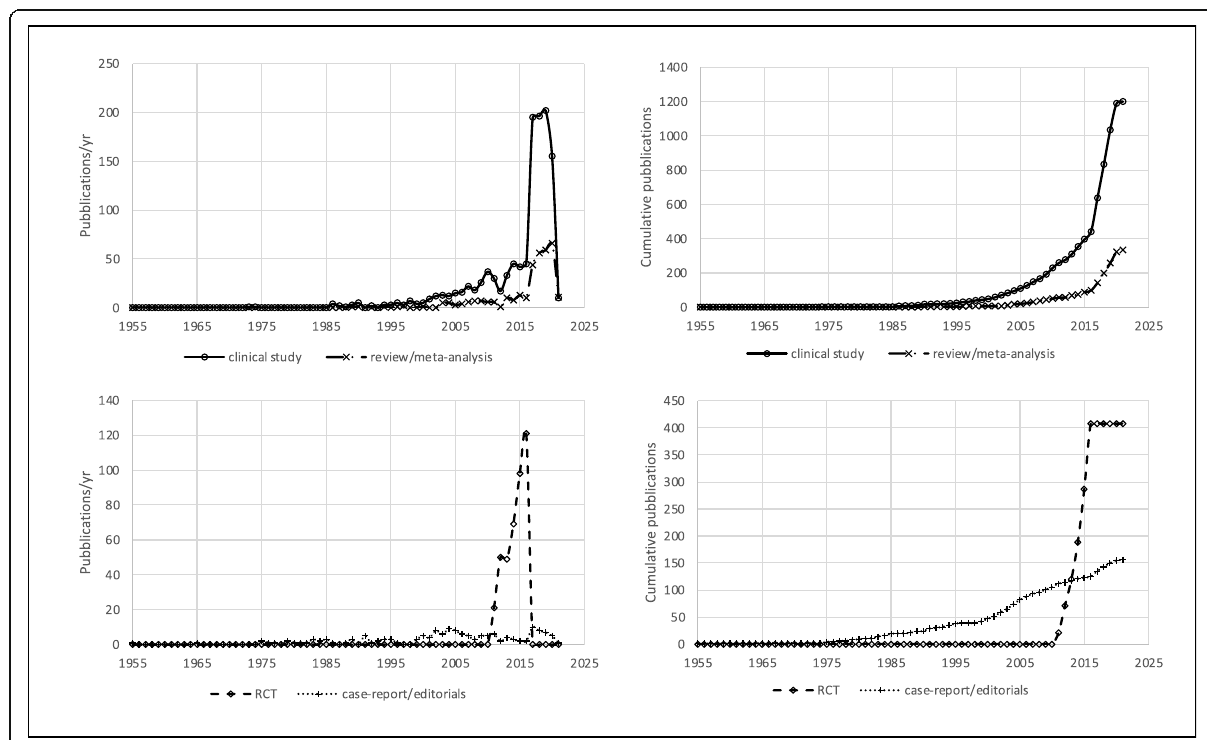
Fig. 5 Number of papers on PND published annually (left) and cumulatively (right) according to type of